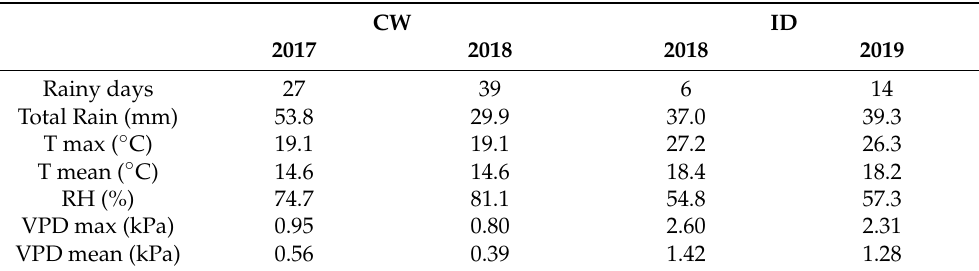
Table 1. Number of days with rainfall (Rainy days), total rainfall, mean daily maximum temperature (T max), mean daily temperature (T mean), mean daily daylight hour relative humidity (RH), mean daily maximum vapor pressure deficit (VPD max), and mean daily daylight hour vapor pressure deficit (VPD mean) for the first two summers (June–August) at the coastal wet (CW) and inland dry (ID) sites in western